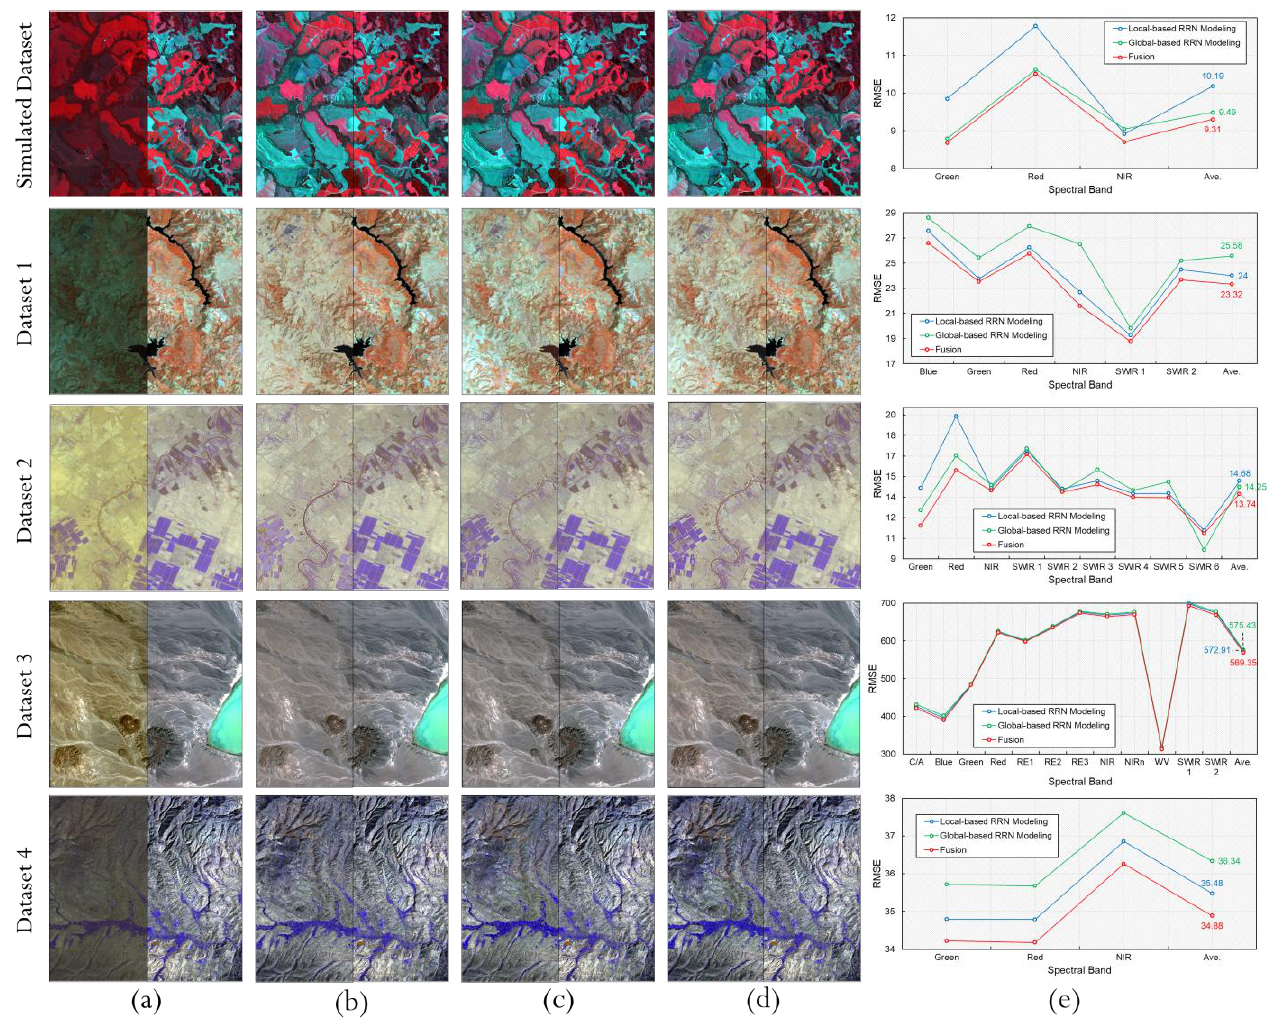
Figure 7. The comparative results of the proposed SRRN method using the local, global and fusion- based RRN modeling. The mosaic images are composed of ( a ) subject images (left) and reference images (right), ( b ) normalized images generated through the local RRN model (left) and reference images (right), ( c ) normalized images generated through global RRN model (left) and reference images (right), and ( d ) normalized image generated through fusion-based RRN model (left) and reference images (right) for all analyzed datasets. ( e ) The performance resulted from local, global, and the proposed fusion strategy models over all spectral bands of analyzed datasets.